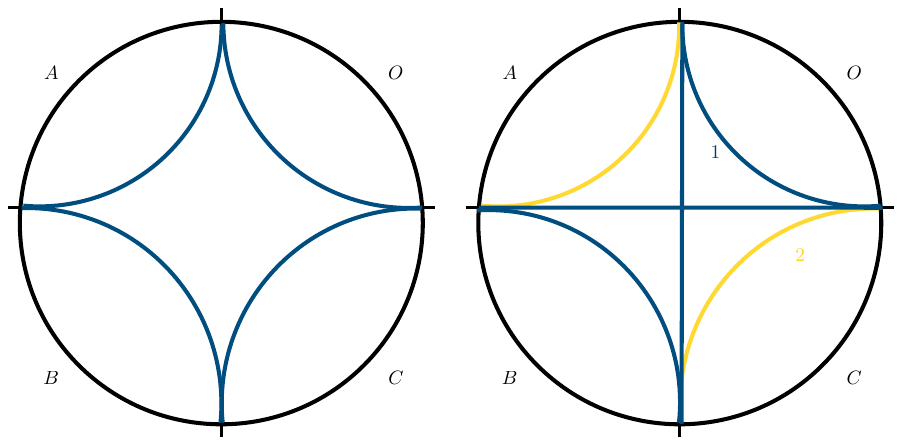
Figure 13 . We consider a static time slice of vacuum AdS 3 with three regions A, B, C along with the purifier O . First we place a barrier in the manifold corresponding to each of the RT surfaces whose area gives the entanglement entropy. In order to show this configuration is minimal it is necessary to construct a corresponding maximal configuration. This is hard to do in the context of necessarily optimal and only provides an upper bound. L: first we place barriers on each of the single party RT surfaces m . R: we place barrier on the two party RT surfaces A , m B , m C , m ABC m AB , m BC , m AC . Note here that m AC = m A ∪ m C so that the total barrier on these surfaces is 2 emphasized here in yellow.